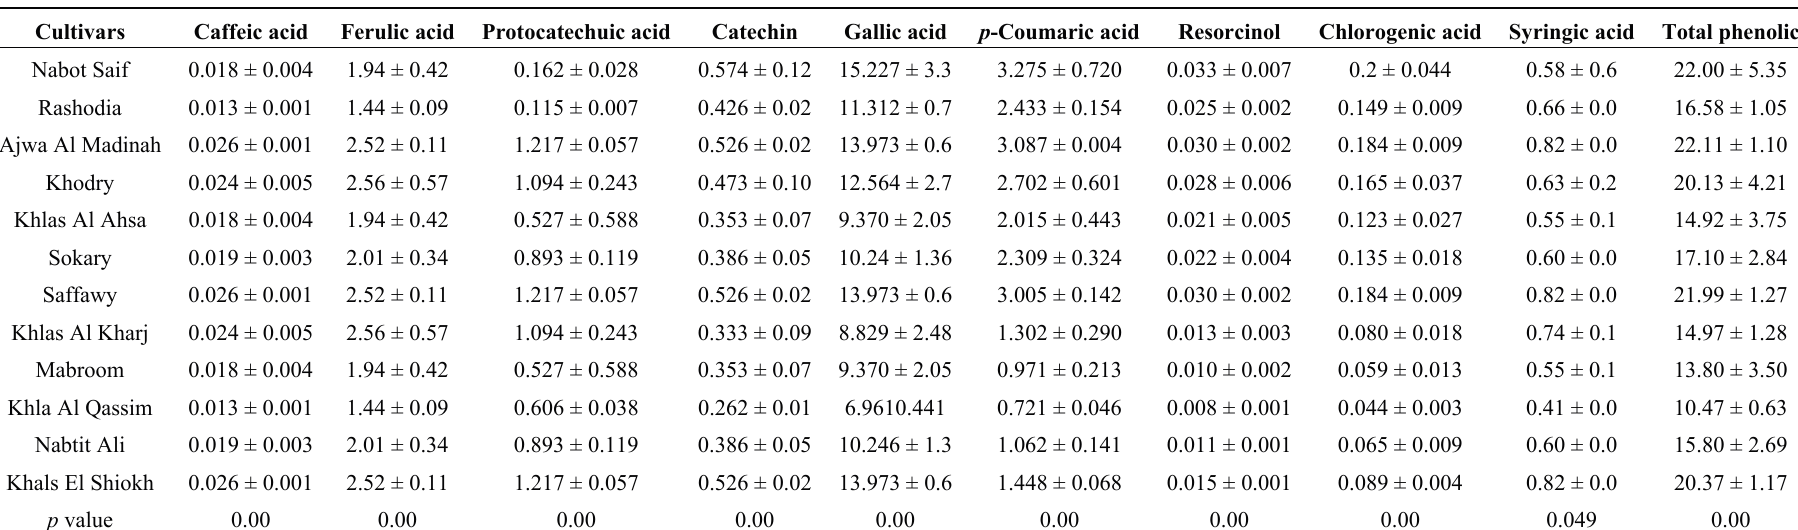
Table 4. Concentrations of phenolic compounds (mg/100 g DW) in 12 Saudi date cultivars.